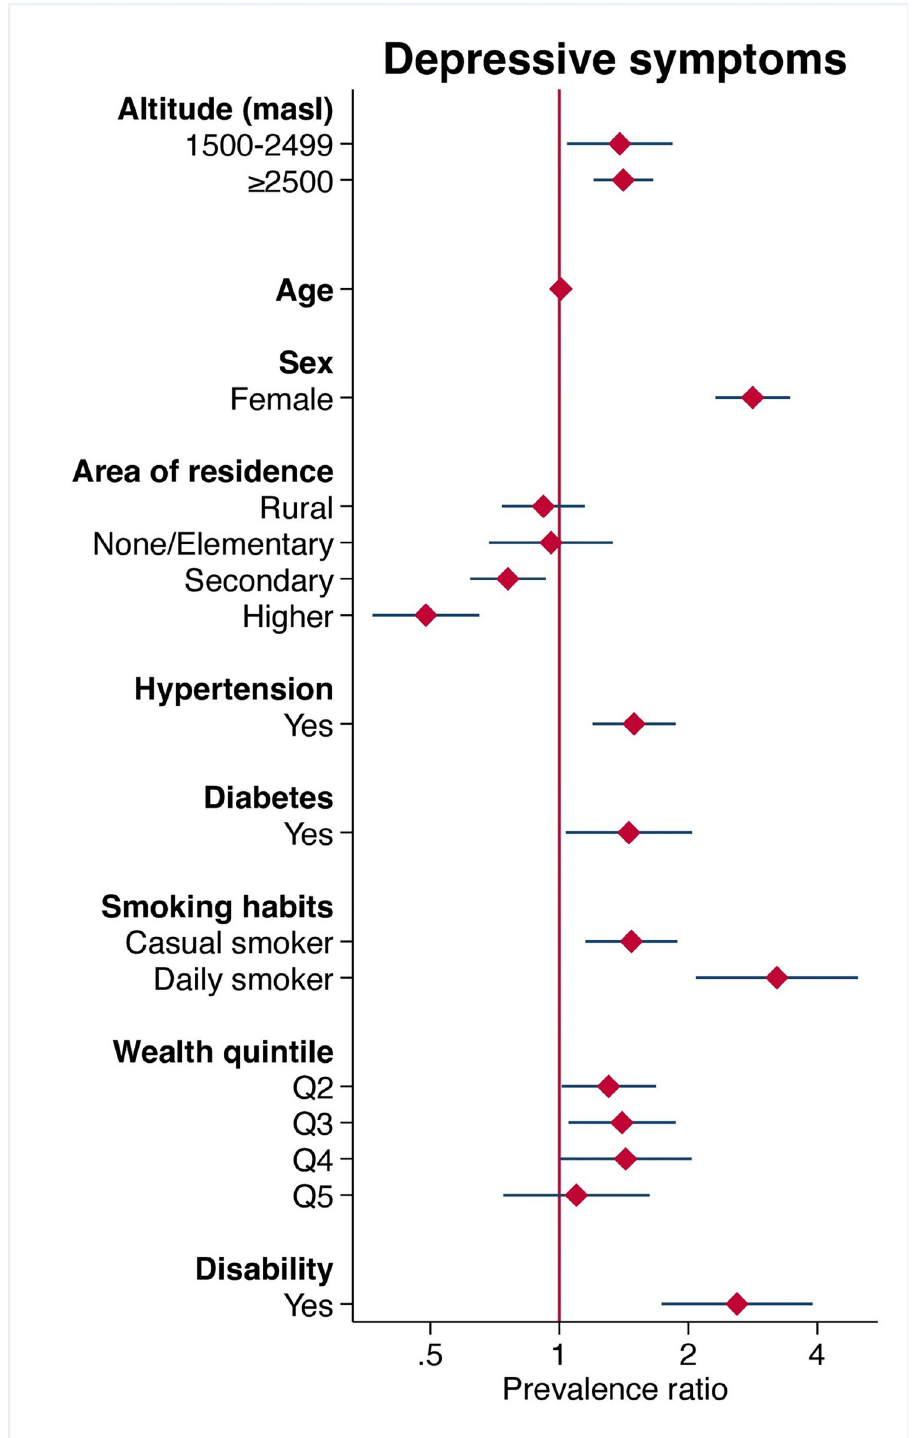
Fig 2. Forest plot of the adjusted association between altitude of residence and presence of depressive symptoms.